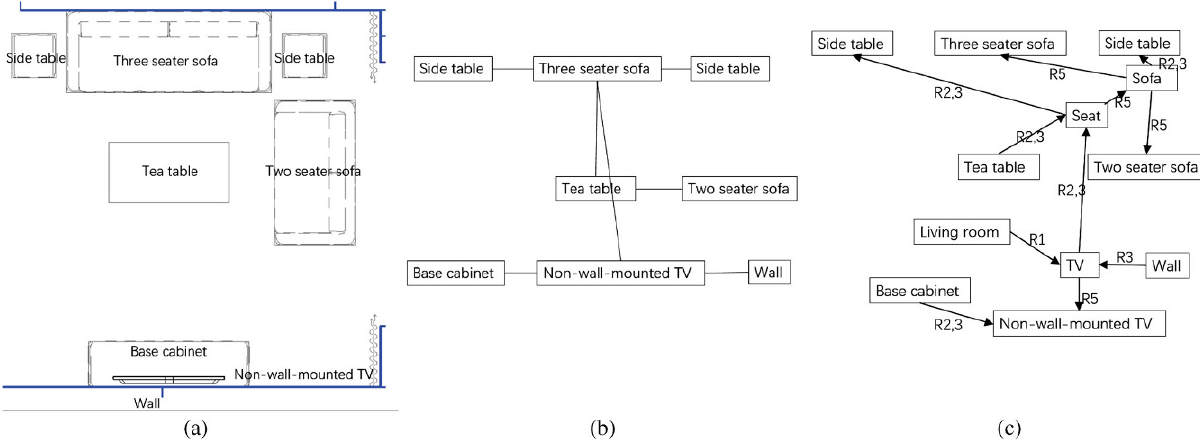
Fig. 3 A typical indoor scene and its corresponding graph-based representation, which is a subgraph of our knowledge graph. (a) A corner of a room provided by an indoor designer. (b) A scene graph from the work [25]. (c) Our graph-based representation. To simplify this graph for drawing, we have removed nodes representing instances and corresponding is an instance of